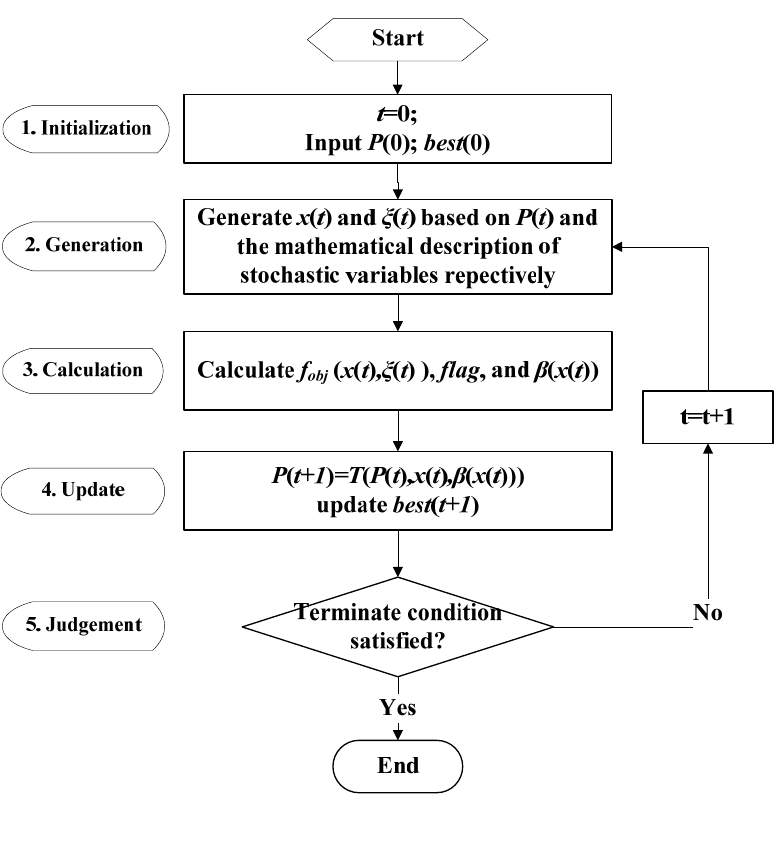
Figure 1. Flow chart of the FALA-based